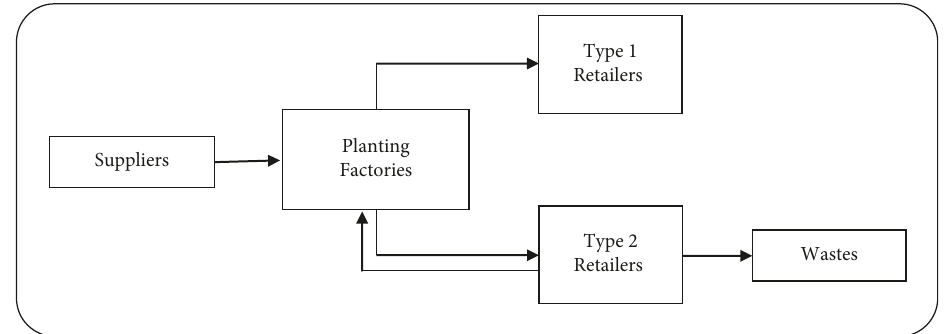
Figure 1: The closed-loop supply chain of domestic